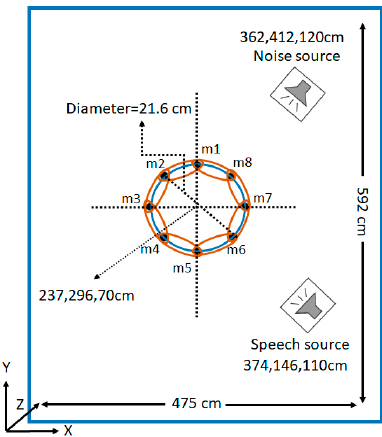
Figure 7. A view of the simulated room with the positions of speakers, noise source, and microphones.